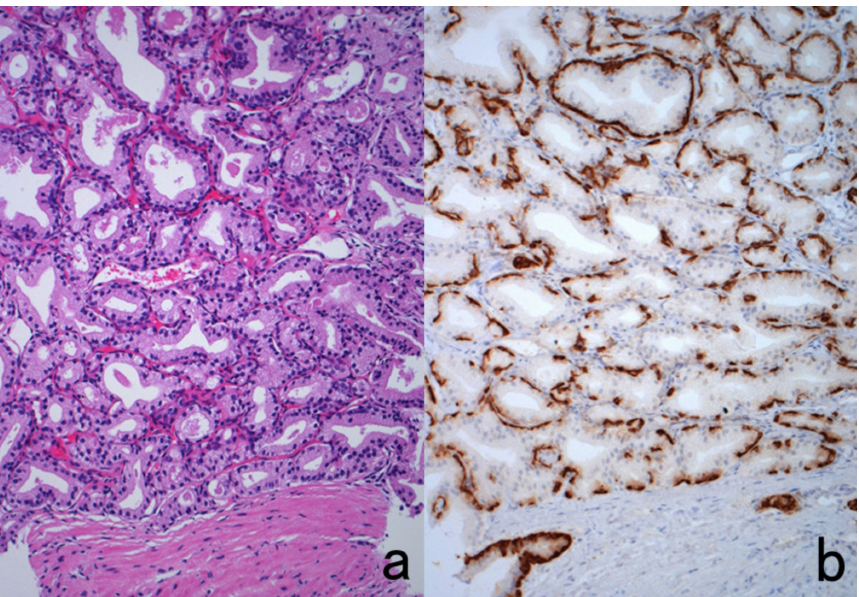
Figure 52. Post-atrophic hyperplasia of the prostate. ( a ): H&E and ( b ): immunostaining for cytoker- atin 5/6. H&E histology resembles well-differentiated prostatic adenocarcinoma. Immunostaining for cytokeratin 5/6, a basal cell marker, clearly shows the consistent association of basal cells around the acini, definitely indicating a benign lesion.